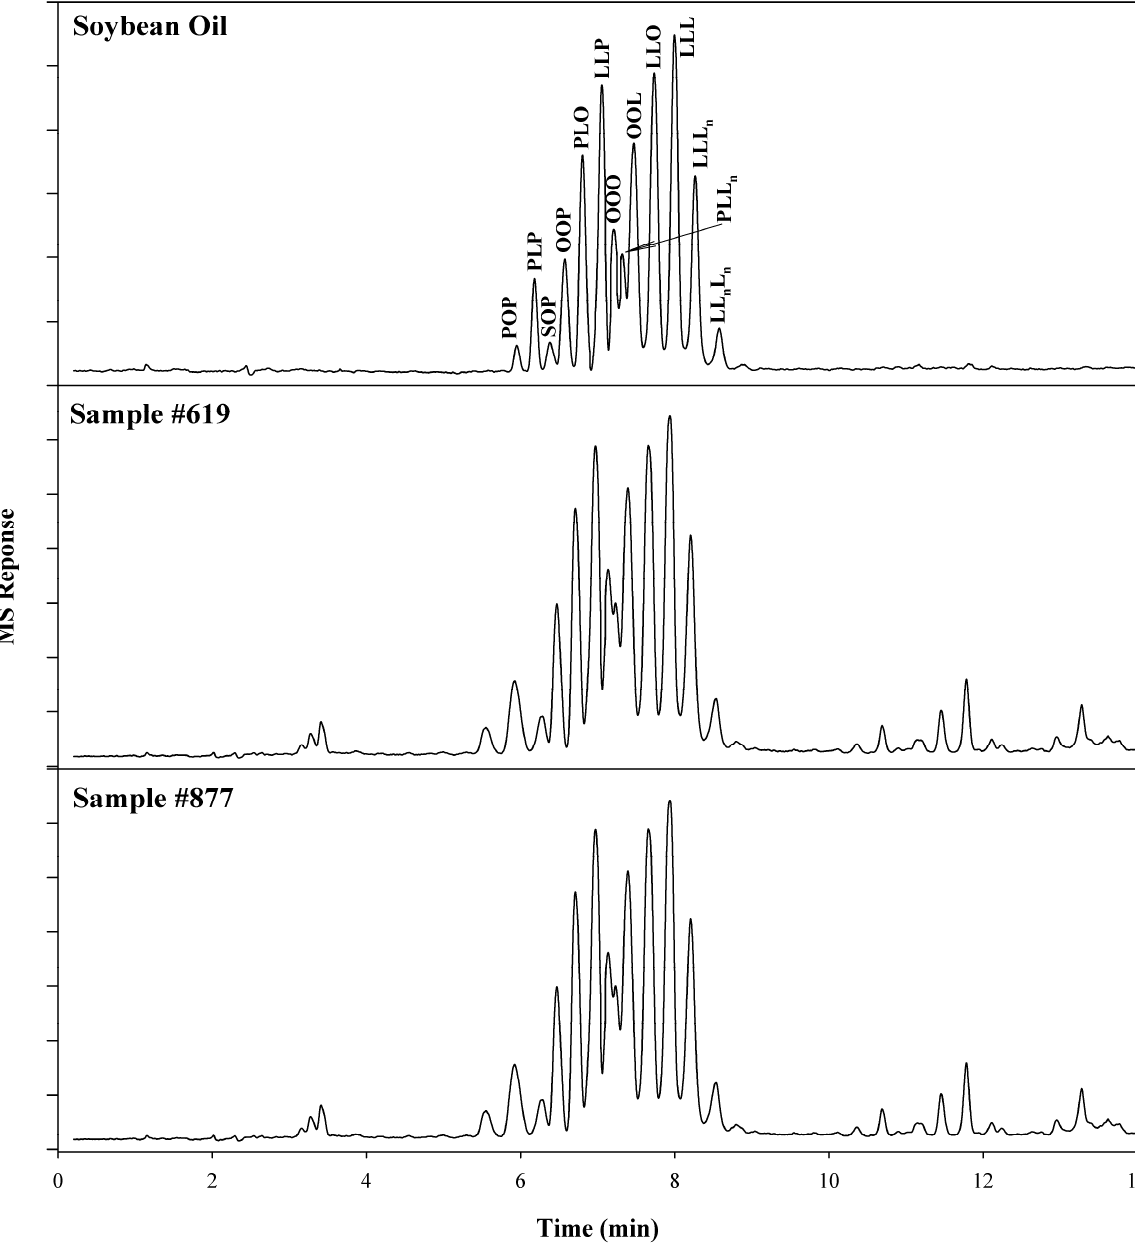
Figure 7. SFC/MS total ion chromatograms of a soybean oil standard and two adulterated commercial samples containing soybean oil.